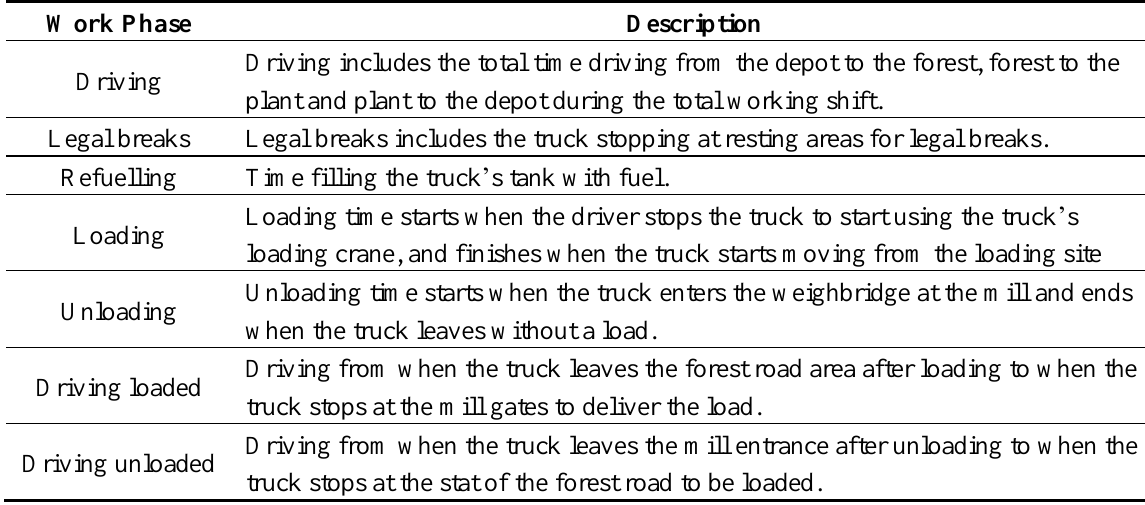
Table 1. Main work phases on the working